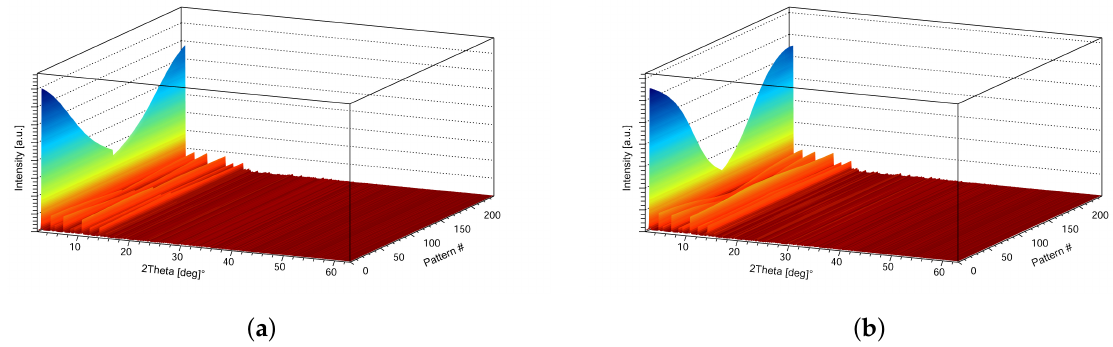
Figure 1. In situ X-ray powder-diffraction (XRPD) data during adsorption and desorption of CO 2 ( left ) and Xe ( right ) into a Y zeolite. ( a ) Data matrix of CO 2 . ( b ) Data matrix of Xe.